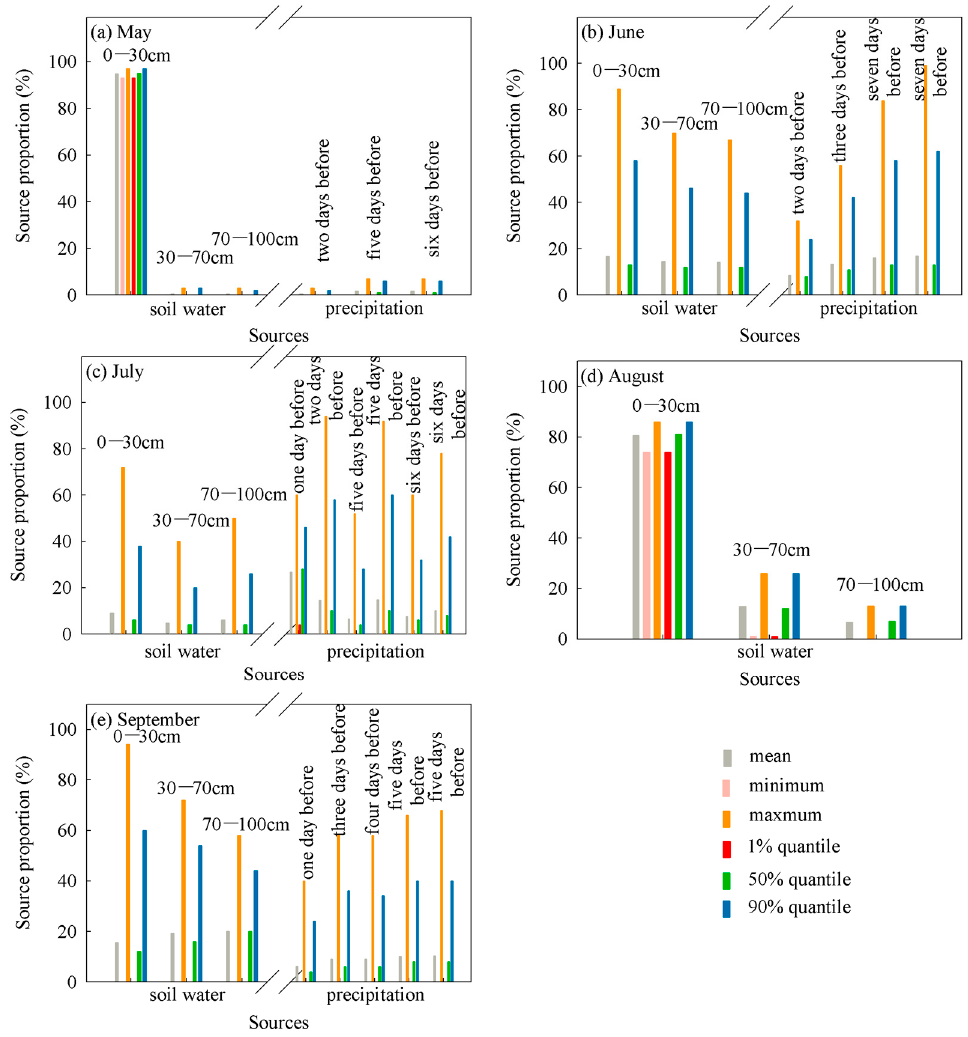
Figure 11. The fraction of plant water use from the different soil layers (0–30 cm, 30–70 cm, 70–100 cm) and precipitation at Wushaoling. ( a ), ( b ), ( c ), ( d ) and ( e ) represent the months of May, June, July, August, and September, respectively.